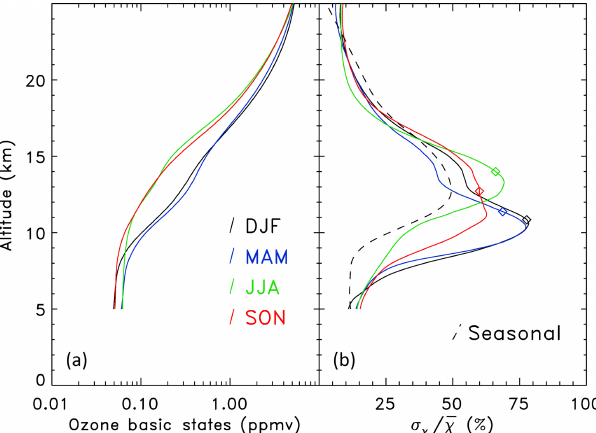
Figure 7. Seasonal means of ozone basic states profiles from Boul- der over the years 1991–2015 (a) and normalized standard devia- tions of the basic states (b) . The means and intra-seasonal standard deviations were taken over the periods December–February (DJF, black), March–May (MAM, blue), June–August (JJA, green), and September–November (SON, red). The standard deviations were normalized by mean values at each altitude, and seasonal mean tropopause heights are indicated by colored triangles. Also shown is comparable magnitude of the seasonal variation in basic states (dashed curve, b ), estimated from the variance in the four seasonal basic states and normalized by the annual mean. Note that this sea- √ sonal magnitude is equivalent to A p / 2 for a cosine seasonal vari- ation, where A p is the peak relative